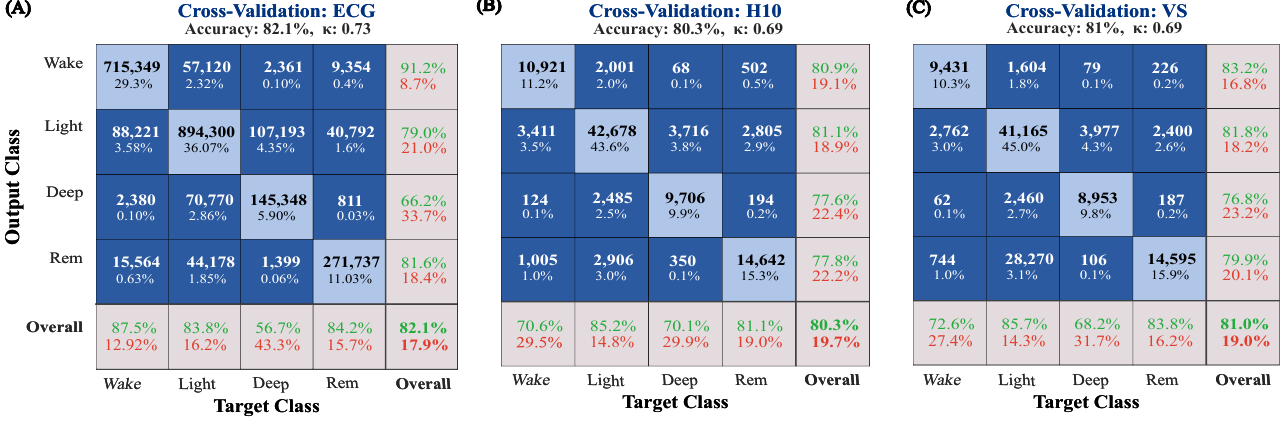
Figure 2. Confusion matrices. ( A ) The MCNN was cross-validated after training on automatically extracted IBIs of the large and manually sleep-staged dataset. The same algorithm was adjusted and cross-validated ON the small dataset with the two wearable sensors ( B ) H10 and ( C ) VS. The rows correspond to the predicted class (output class) and the columns correspond to the true class (target class). The diagonal cells correspond to observations that are correctly classified, whereas the off-diagonal cells correspond to incorrectly classified observations. Both the number of observations and the percentage of the total number of observations are shown in each cell. The gray squares on the right of each matrix include the precision (positive predictive value) and false discovery rates while the ones at the bottom display the recall (or true positive rate) and false negative rate, respectively. The cell in the bottom right corner shows the overall classification